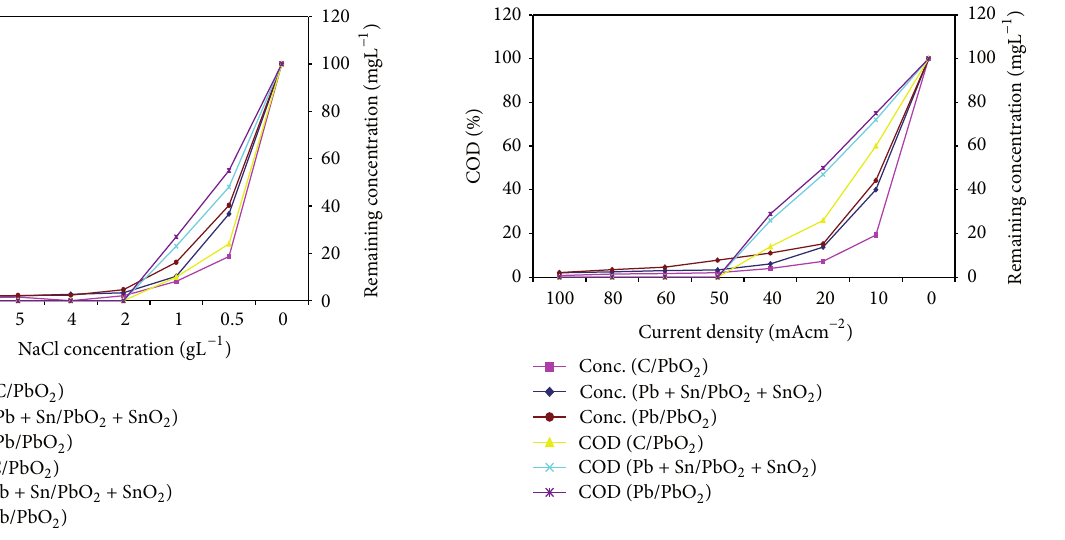
F 2: e effect of NaCl concentration on RY160 and COD removal using C/PbO